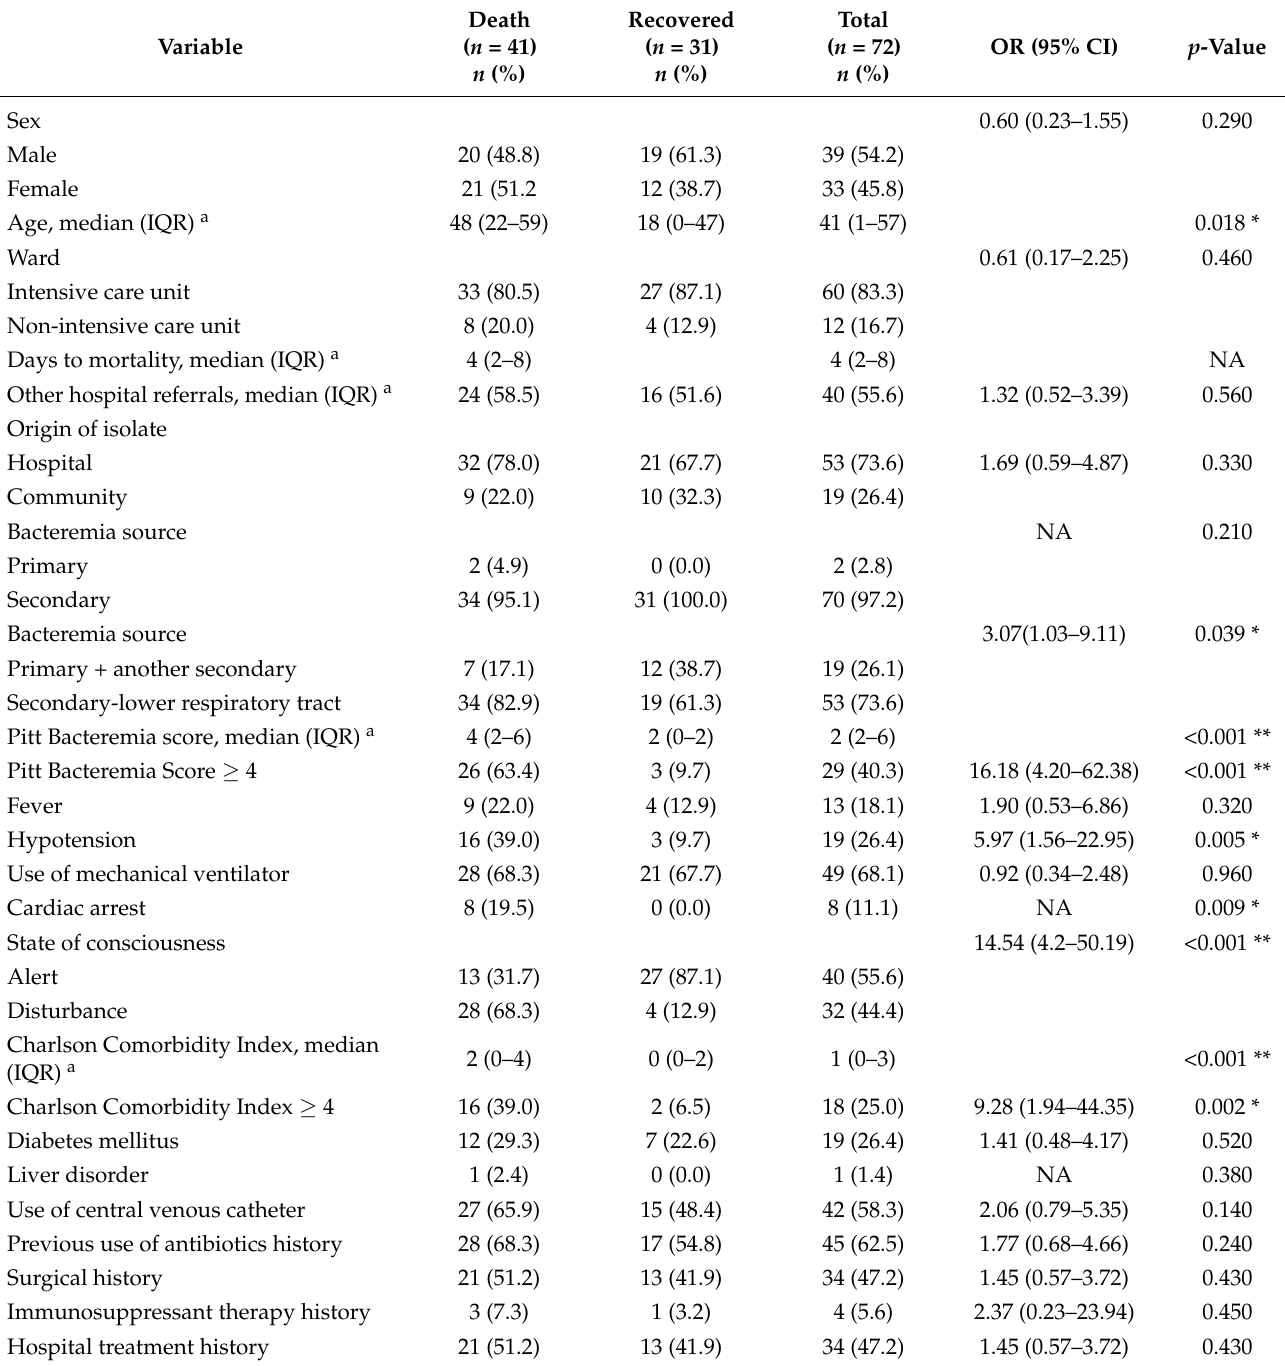
Table 3. Risk factors for mortality of bacteremia caused by CNSAB ( n =